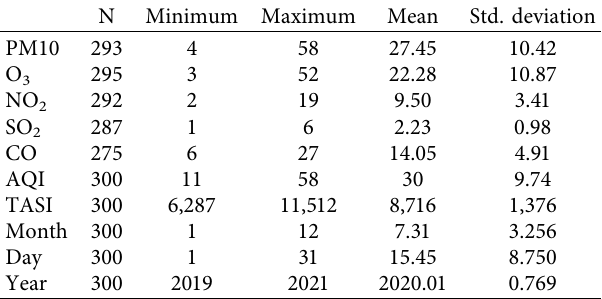
Table 1: Descriptive statistics of the cleaned